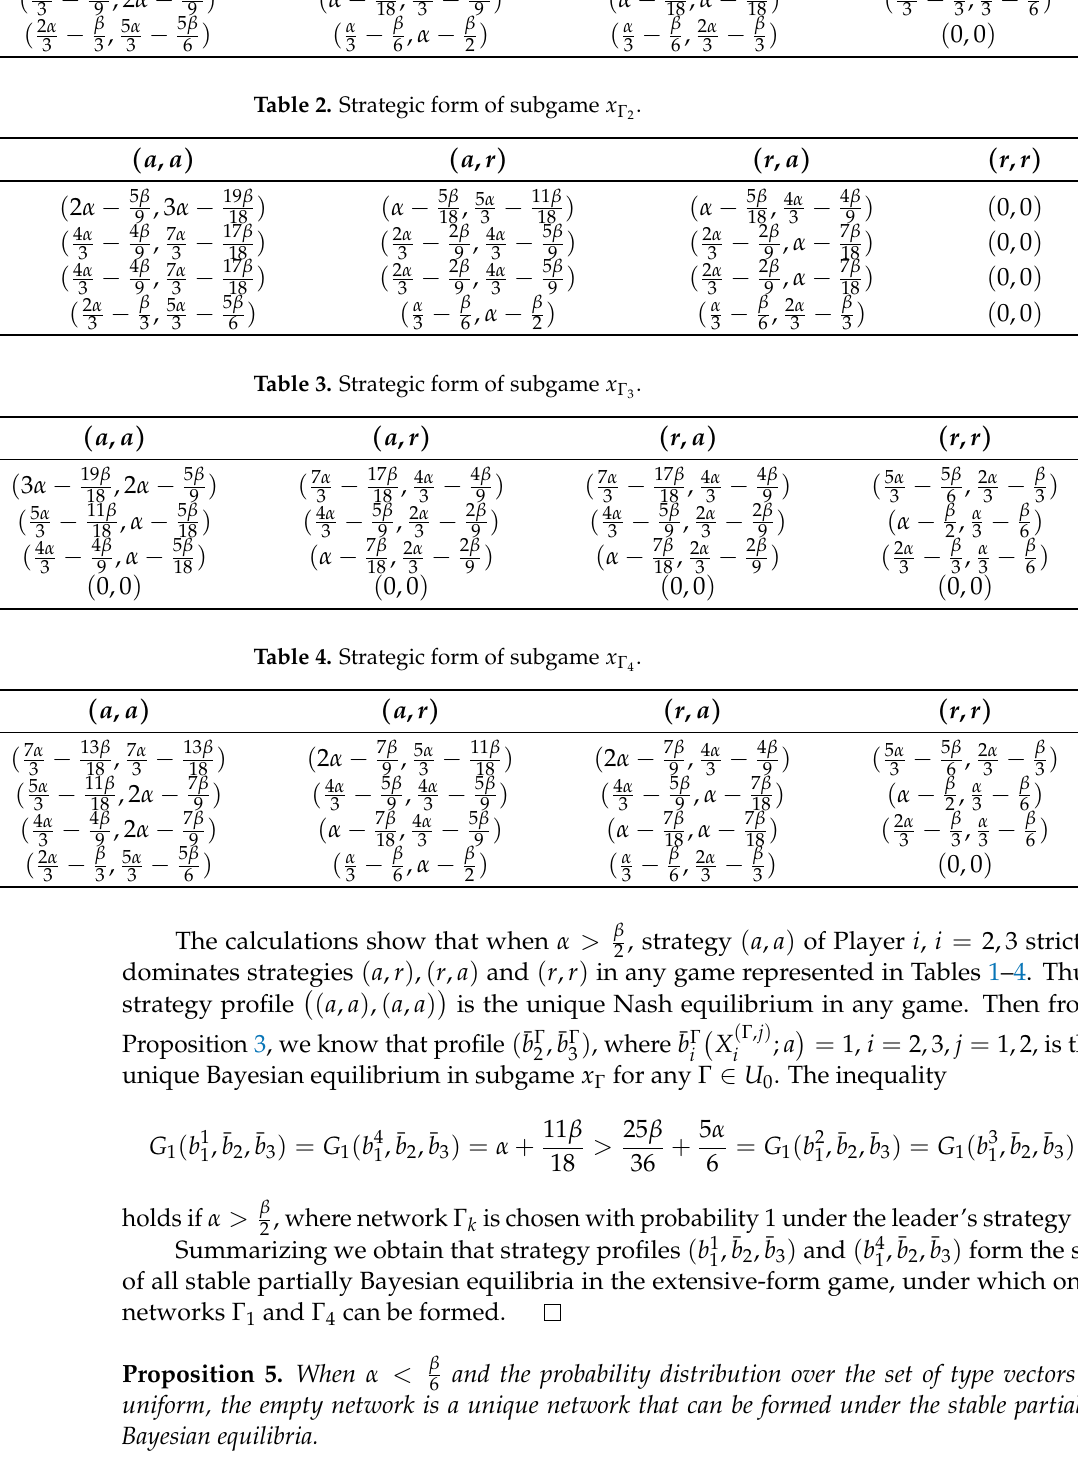
Table 2. Strategic form of subgame x Γ